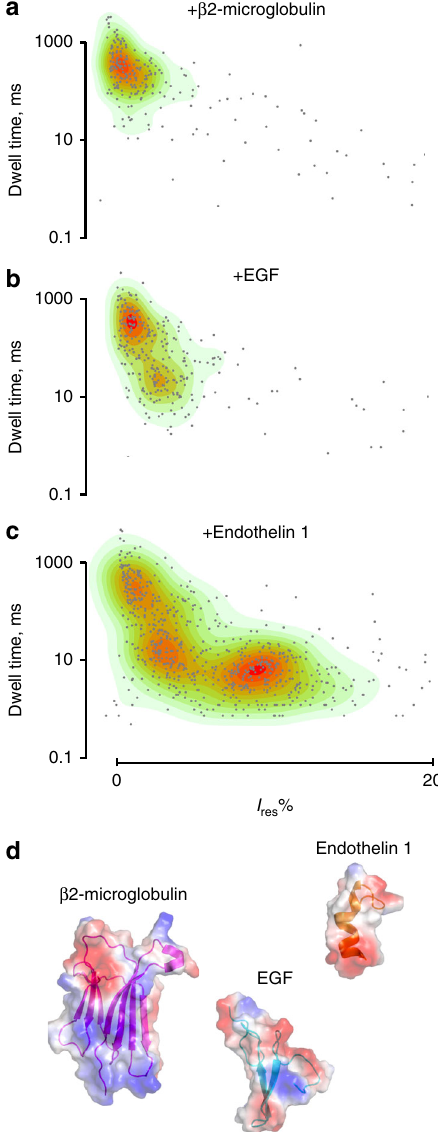
Fig. 4 Discrimination of a biomarker mixture with WtFraC at pH 4.5. A single WtFraC nanopore was obtained in a buffer at pH 4.5 (1 M KCl, 0.1 M citric acid, 180 mM Tris base) under a − 50 mV applied potential. About 200 nM of β 2-microglobulin was initially added to the cis compartment ( a ), then 1 µ M EGF ( b ), and fi nally 200 nM endothelin 1 ( c ) were added to cis compartment. d Crystal structure of β 2-microglobulin, EGF, and